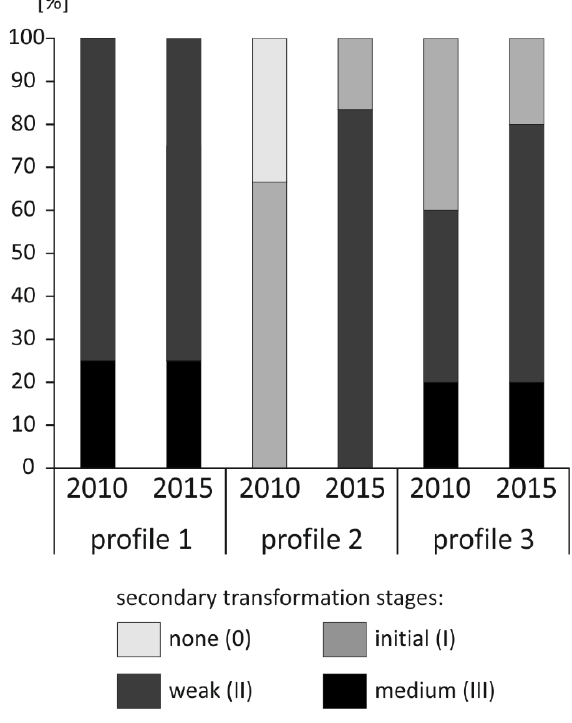
Figure 5. Secondary transformation stages of the studied soil horizons - percentage contribution (2010 and 2015 comparison).